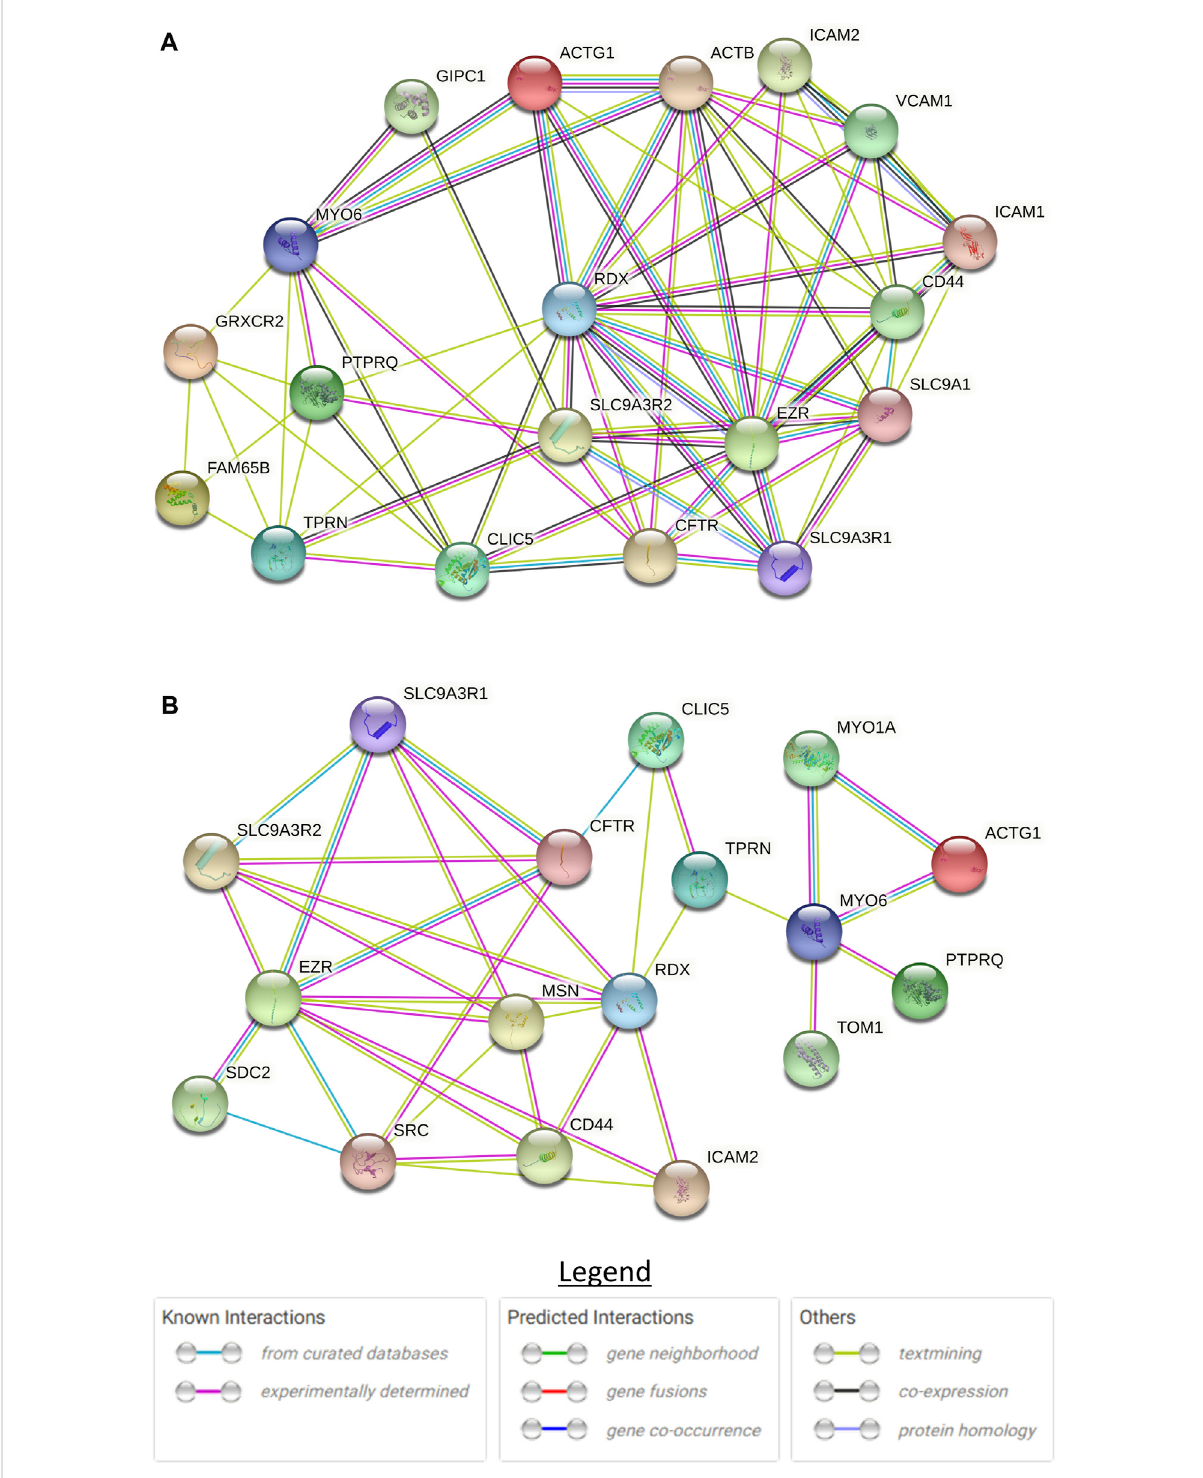
FIGURE 5 STRING protein-protein interaction network of CLIC5. (A) Full protein-protein interaction network consisting of both functional and physical protein interactions. (B) Subnetwork of physical interactions. The circles with structure in them are proteins with known or predicted